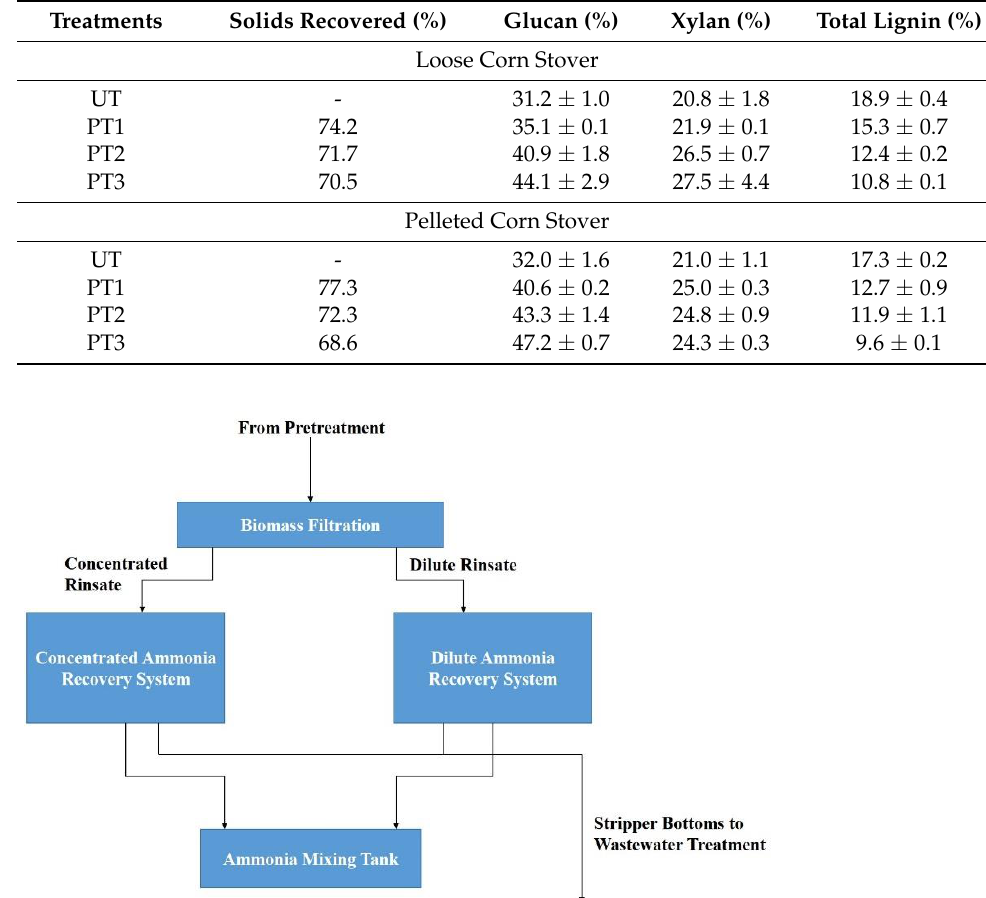
Table A1. Composition of untreated and pretreated loose and pelleted corn stover (adapted from [5]).